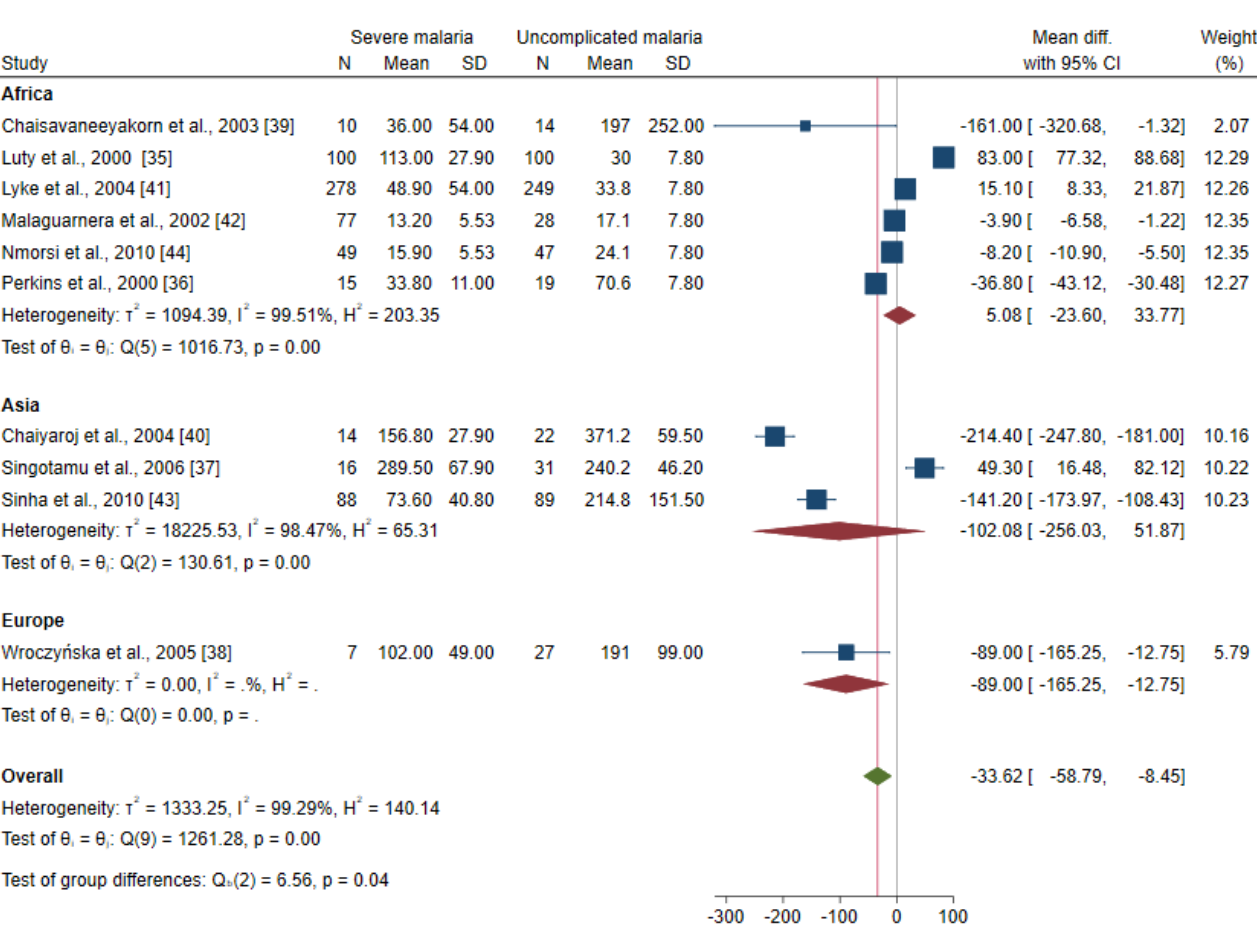
Figure 2. Forrest plot demonstrated the difference in the mean IL-12 levels (pg/mL) between patients with severe malaria and uncomplicated malaria [35–44] . Abbreviation : Mean Diff . , mean difference; CI, confidence interval . Explanation of the forest plot : squared-box symbol, point estimate; green diamond and red line: pooled mean difference: blue line: line of no effect; I 2 , level of heterogeneity; p = 0.00 or less than 0.05, significant heterogeneity.